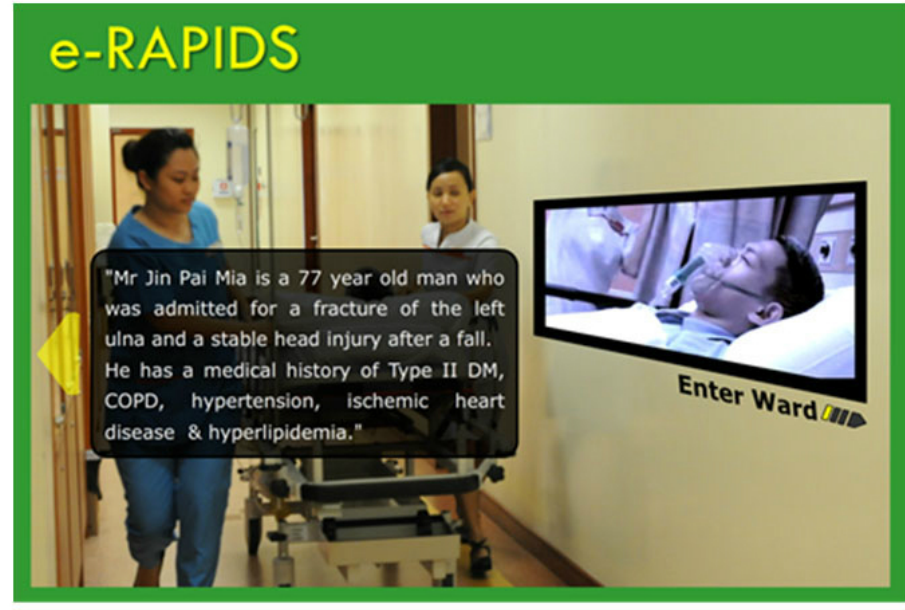
Figure 1. Clinical history of the virtual patient.